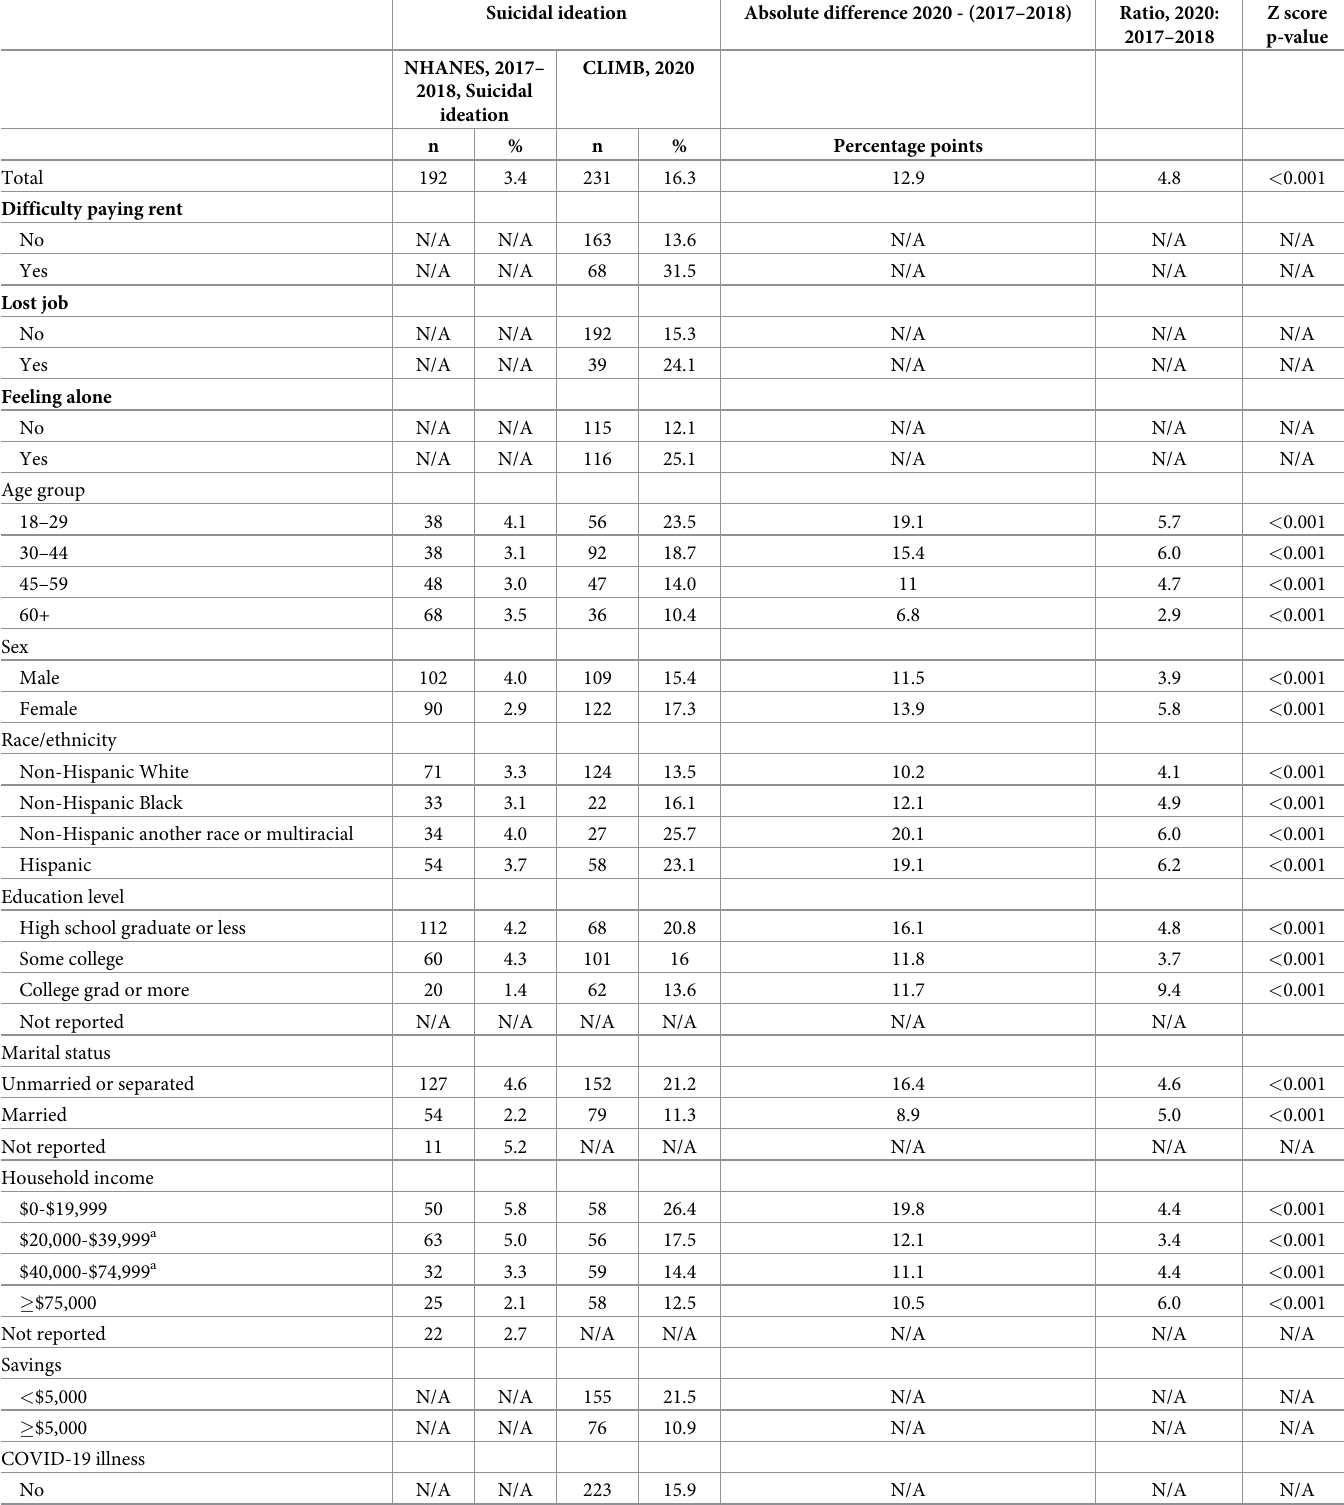
Table 2. COVID-19 stressors, demographic characteristics, and